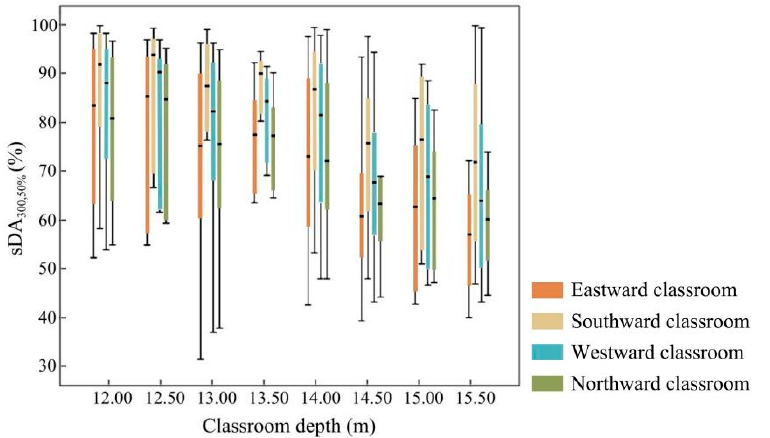
Figure 6. The analysis results of the distribution interval between the classroom depth and the evaluation index.